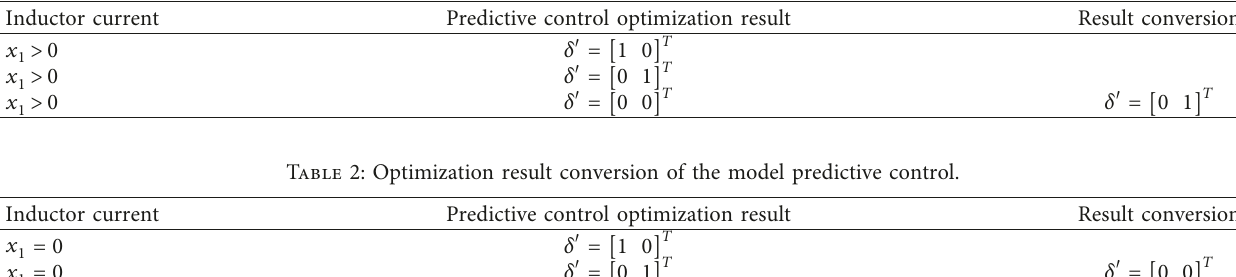
Table 1: Predictive control optimization result conversion.